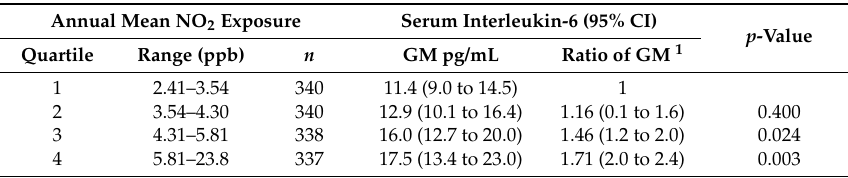
Table 2. Dose–response relationship between annual mean NO 2 exposure and serum interleukin-6 concentrations for all